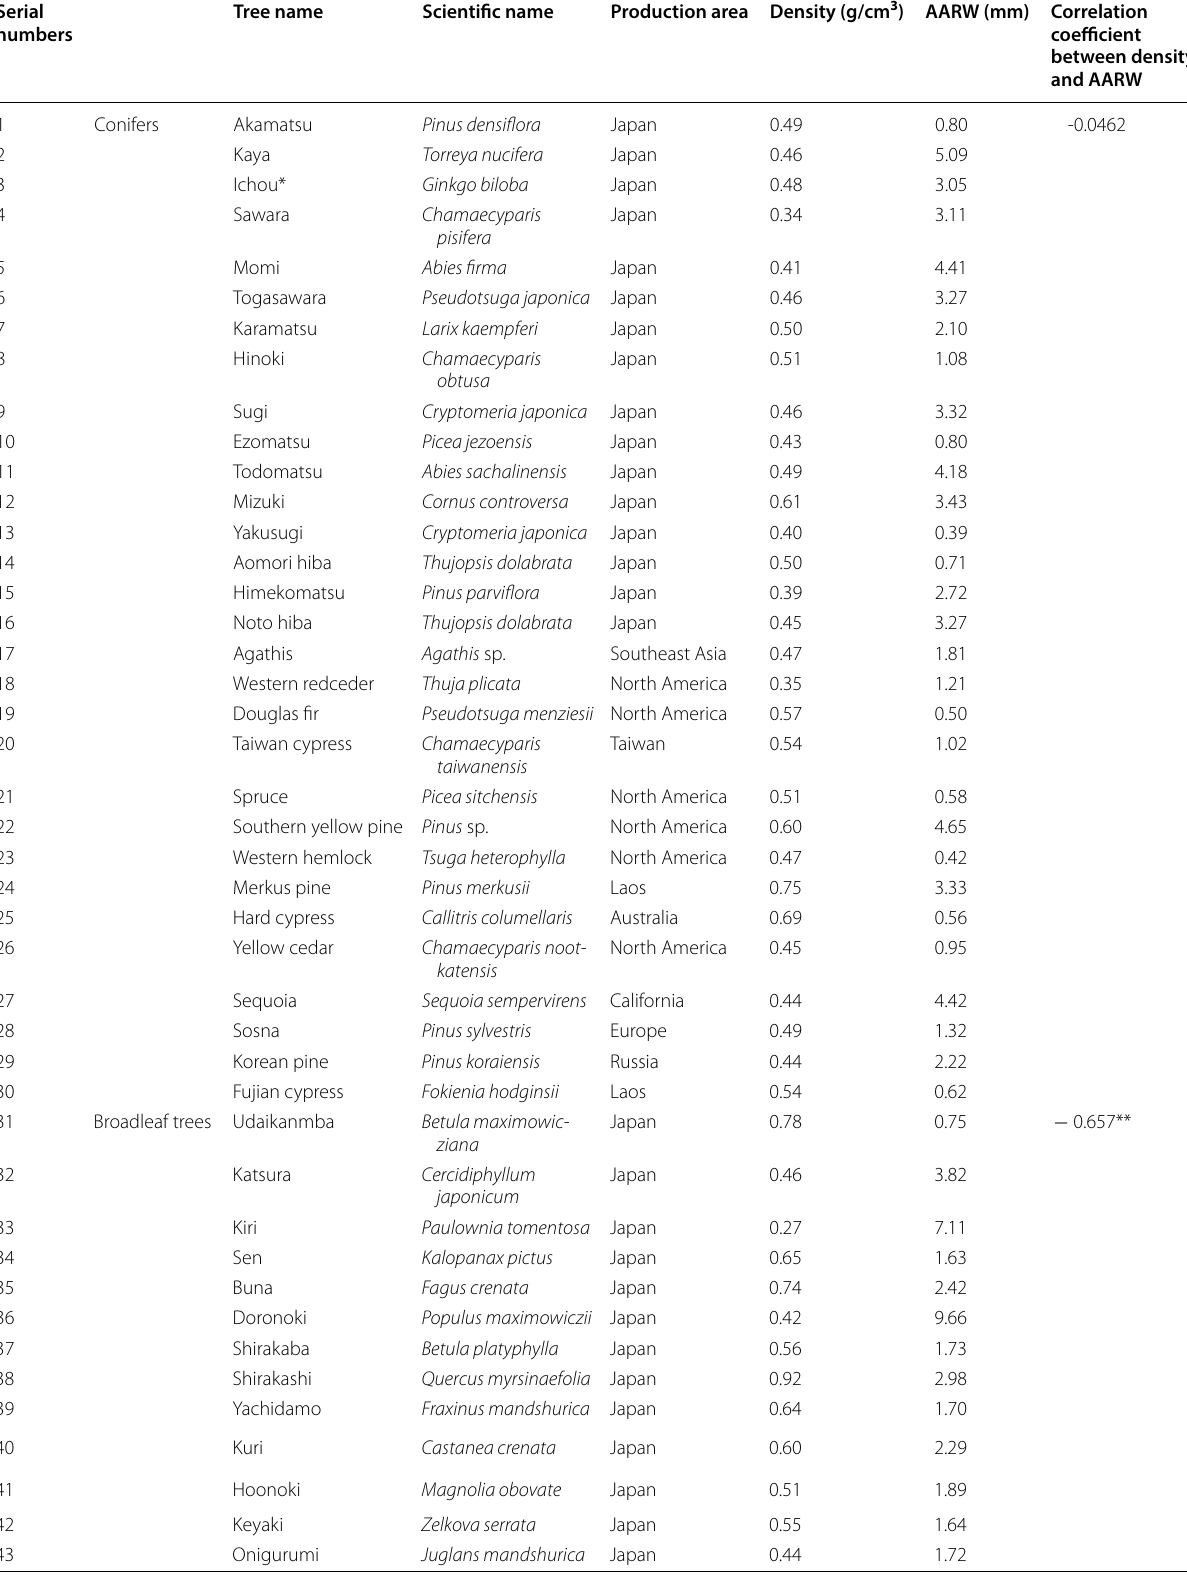
Table 1 Tree name, density, and AARW of each test